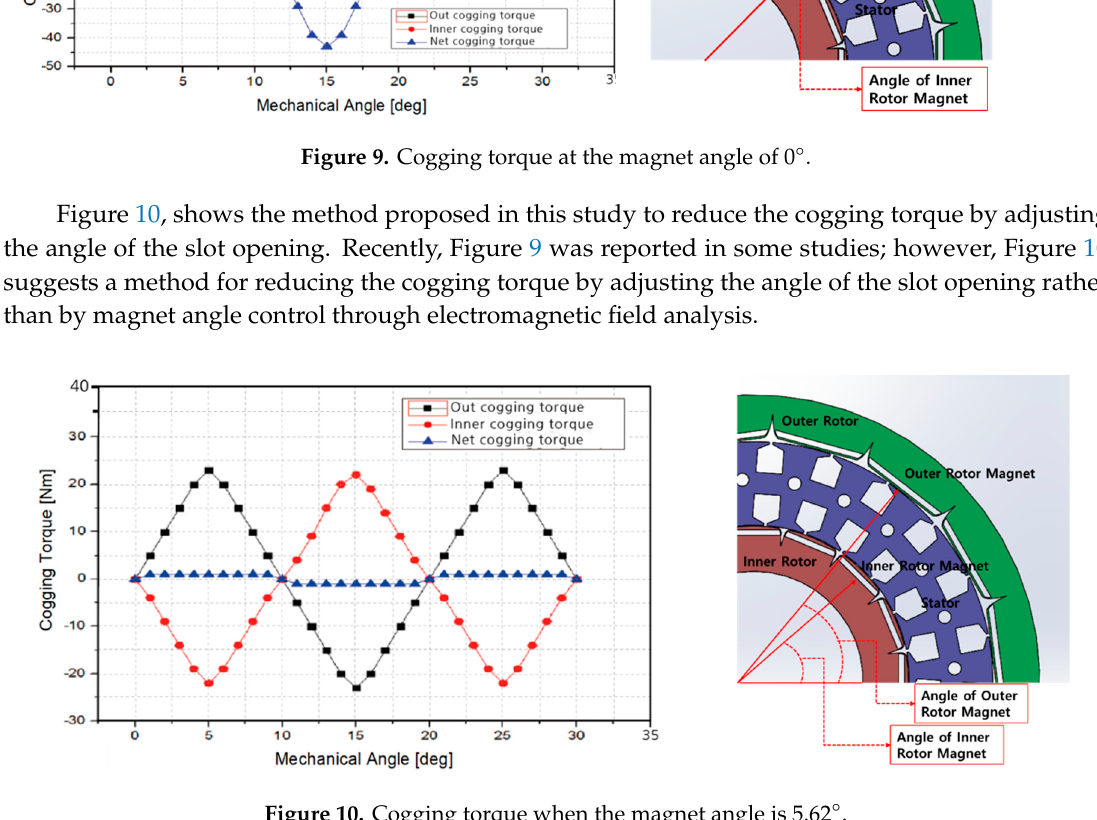
Figure 9. Cogging torque at the magnet angle of 0°.